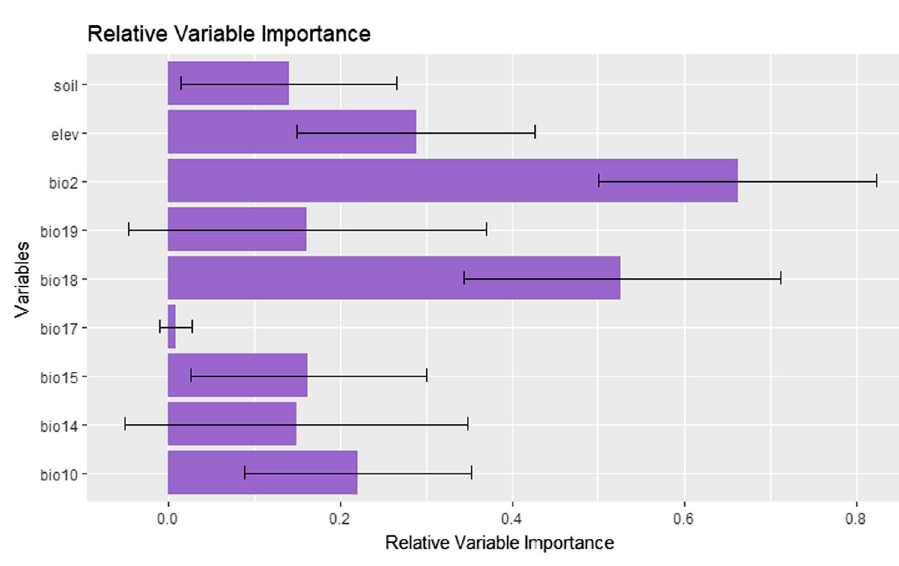
Fig. 2 Histogram of the ensemble variable importance of all variables used to fit the SDMs for Anogeissus leïocarpa (DC.) Guill. & Perr.